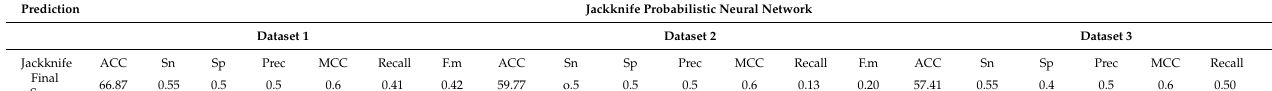
Table 5. Jackknife score based on the Probabilistic Neural Network. Figure 7. Ten-fold Probabilistic Neural Network ROC curve.